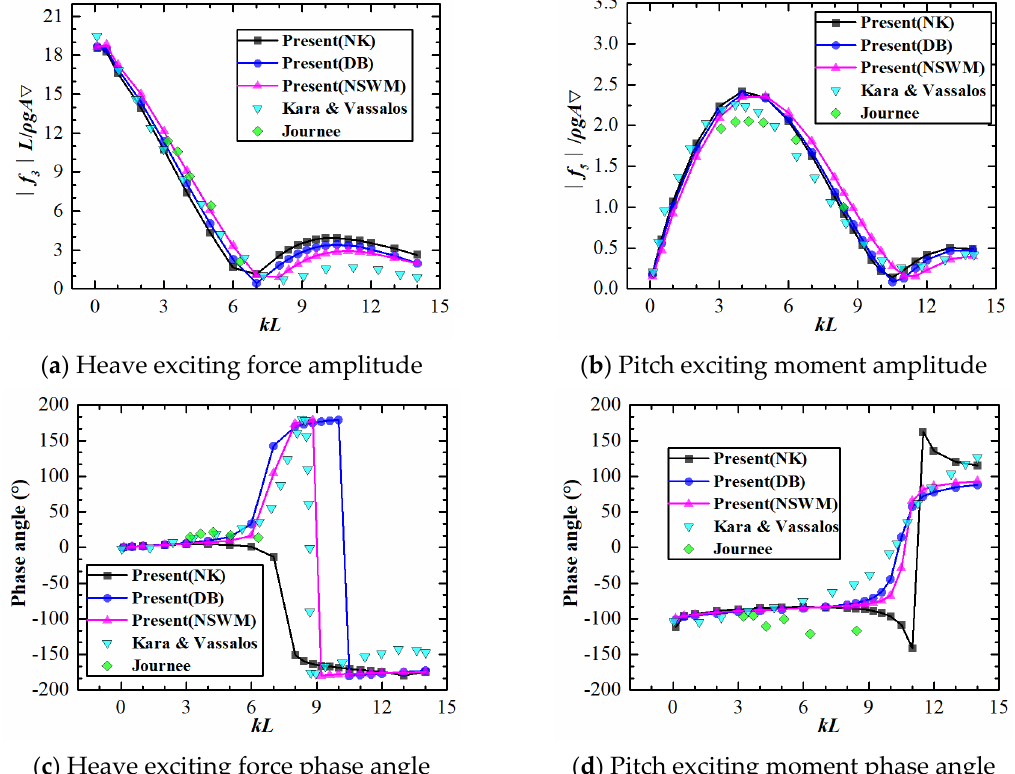
Figure 6. Amplitudes and phase angles of heave and pitch exciting force / moment on Wigley I ship ( Fr = 0.4).